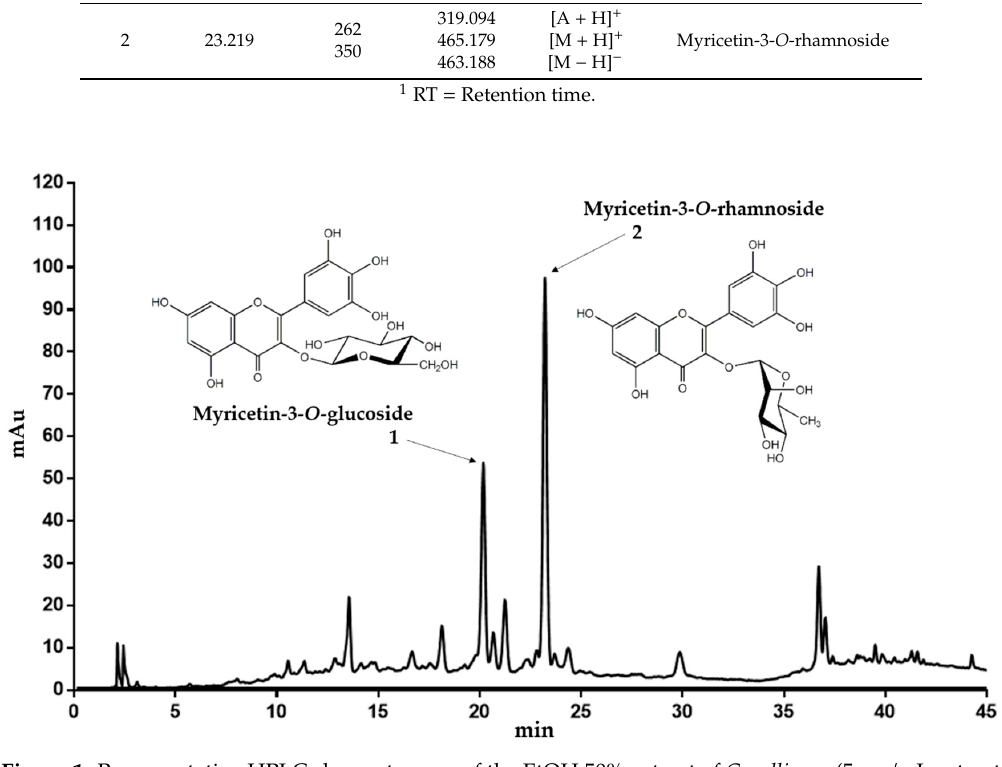
Figure 1. Representative HPLC chromatogram of the EtOH 50% extract of C. collinum (5 mg/mL extract dissolved in ACN 5%, injection volume 20 µL, detection wavelength = 320 nm). The main compounds could be confirmed by LC-MS experiments, 1 H-NMR and spiking experiments.